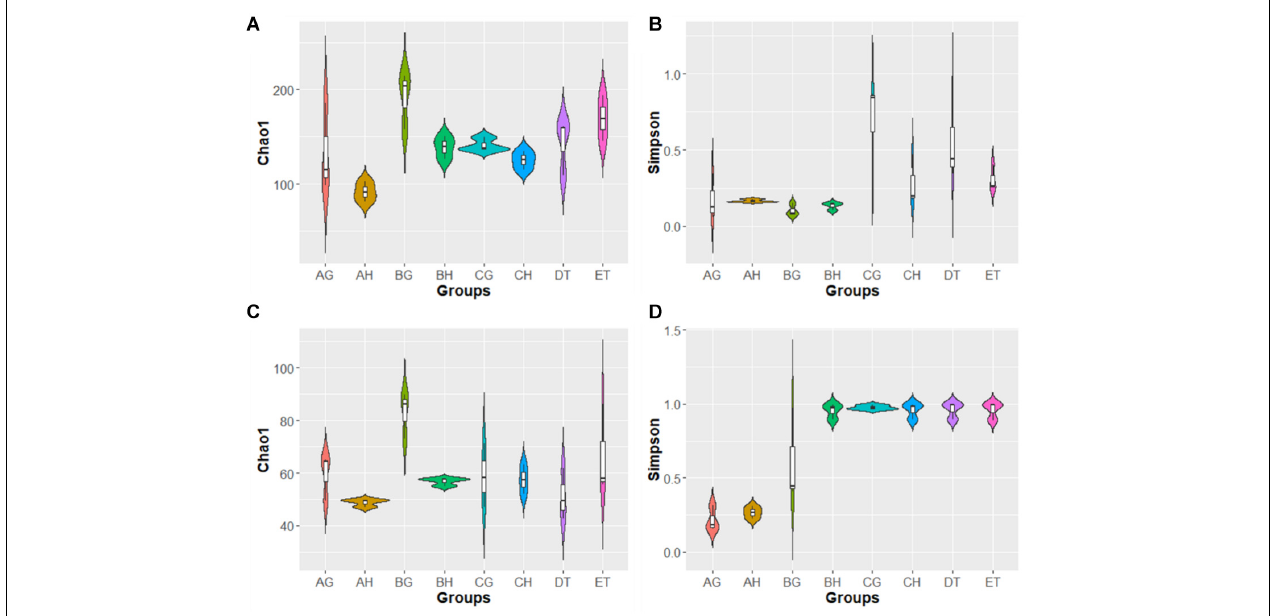
FIGURE 2 | Violin plot of Chao1 and Simpson index of bacterial (A,B) and fungal (C,D) operational taxonomic units (OTUs) among eight samples. AH, BH, and CH were represented as hemolymph samples respectively from sample A (uninjected living larvae), B (living larvae with high blastospore load) and C (freshly mummifying larvae without a mycelial coating); AG, BG, and CG were represented as gut samples respectively also from samples A–C; DT and ET indicated tissue samples from sample D (mummified larvae with mycelial coating) and E (completely mummified larvae with mycelia).